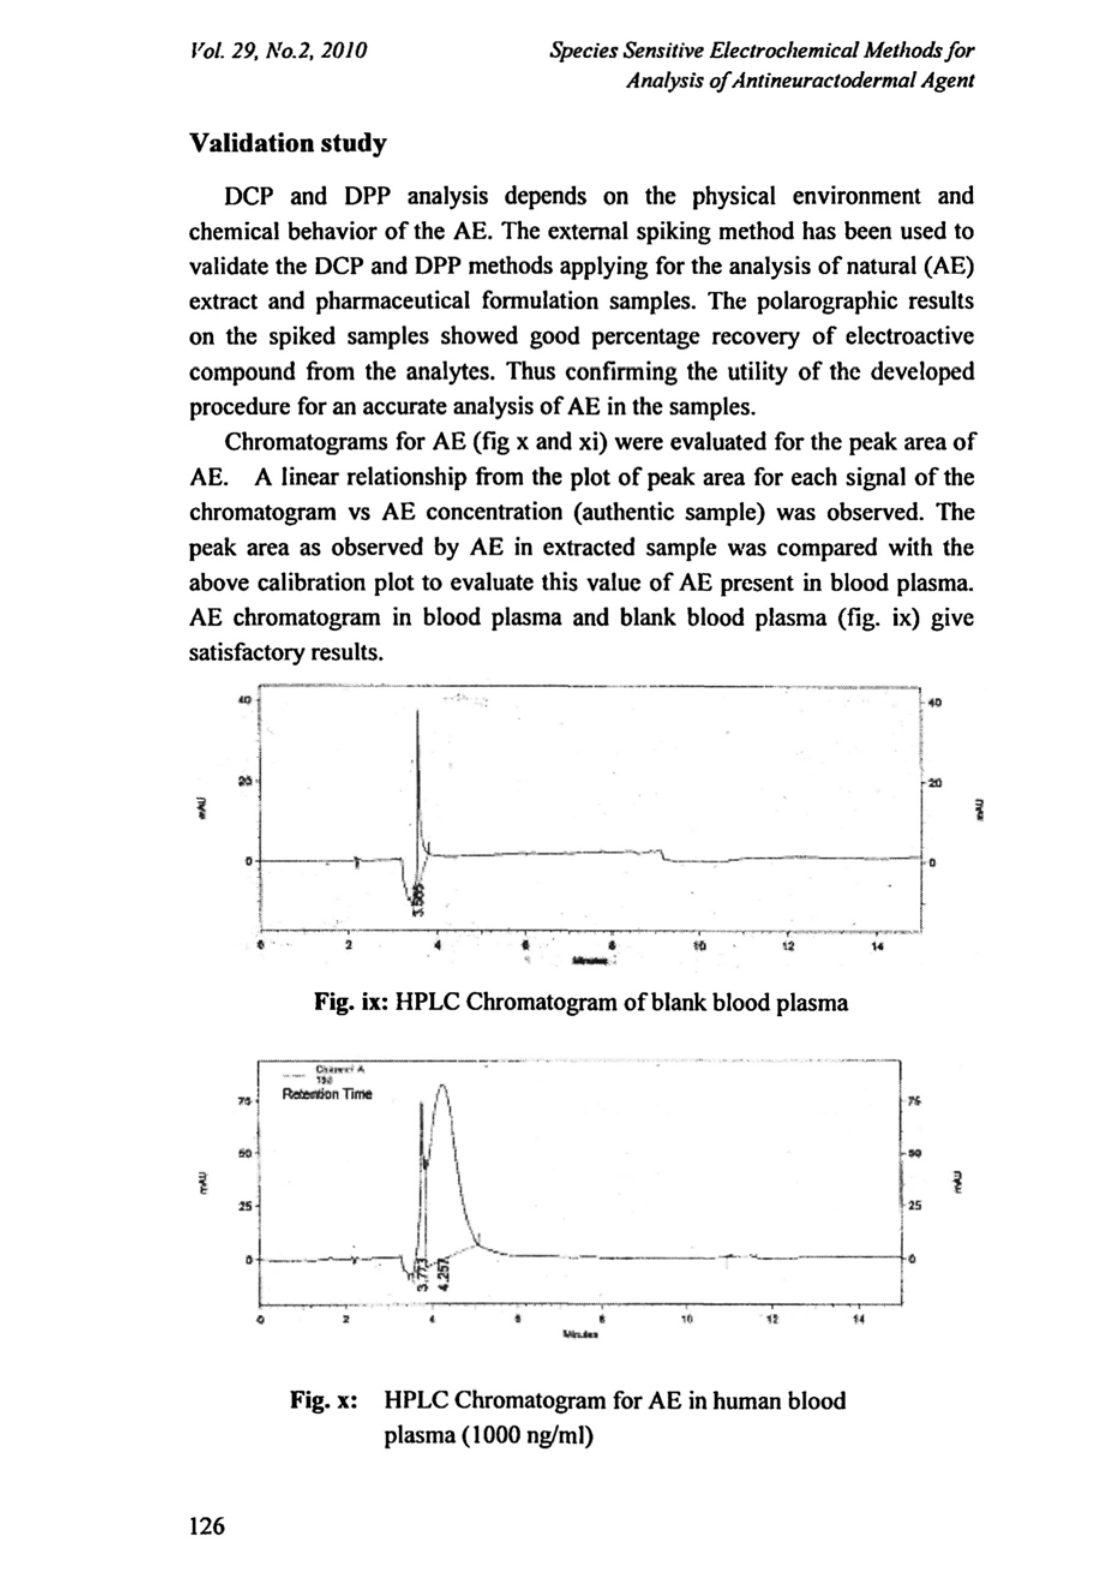
Fig. x: HPLC Chromatogram for AE in human blood plasma (1000